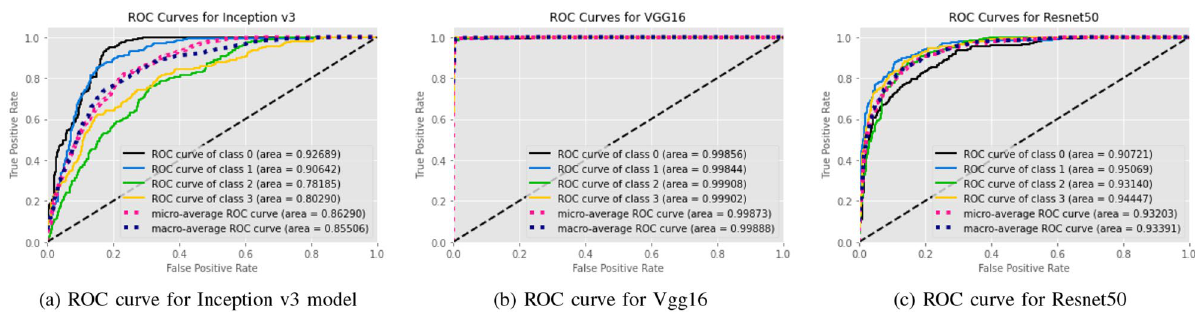
Figure 10. ROC curves for Transfer Based Models Used in Our